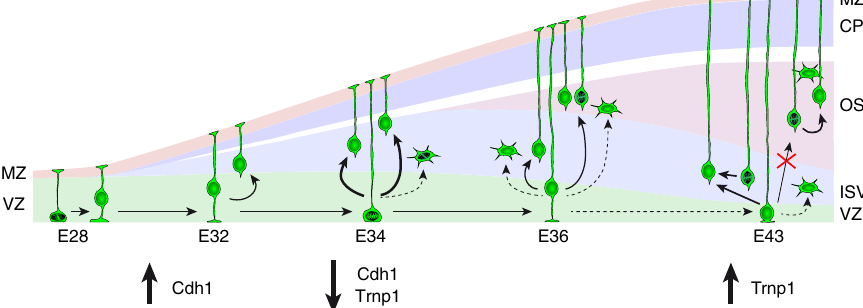
Figure 8 | Model of developmental formation of OSVZ. During an early developmental period aRGCs self-renew, sustained by high levels of Cdh1. Between E34 and E36, a decrease in Cdh1 expression combined with low Trnp1 levels open the critical period for OSVZ formation, driving aRGCs into self- consuming divisions and generating bRGCs massively. These early bRGCs become founder cells of the OSVZ. After birth (E42/P0), a rise in Trnp1 levels blocks the production of bRGCs to the OSVZ and closes this critical period. From this point onward, the OSVZ follows a lineage independent from VZ and ISVZ, sustained by bRGC self-amplification, while VZ continues to seed bRGCs to